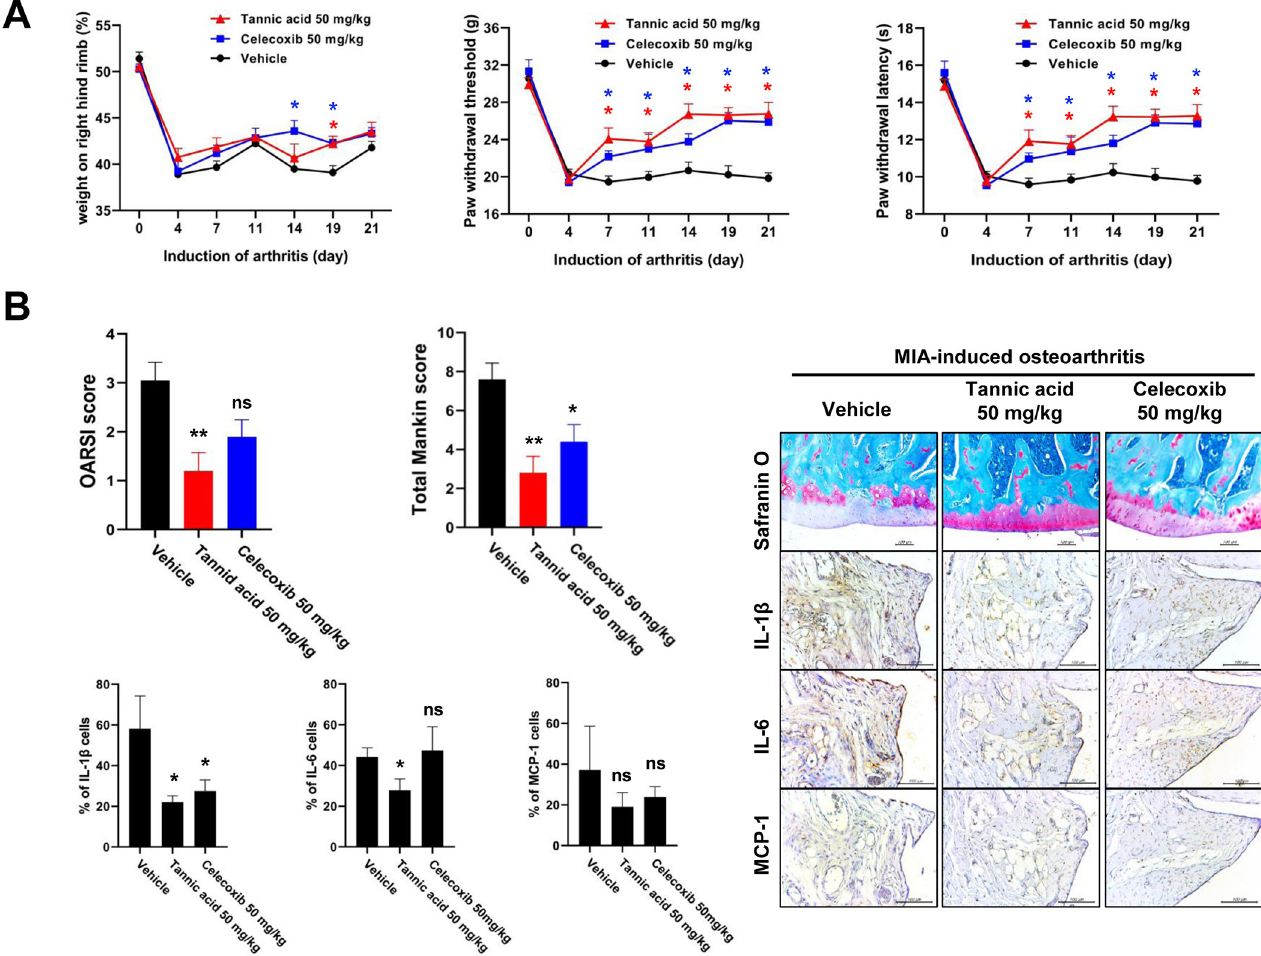
Fig 5. Therapeutic effect of TA in MIA-induced OA rat model. (A) Rats were injected with 1 mg of MIA in the right knee. TA (50 mg/kg) was administered orally daily for 3 days after MIA injection. Behavioral tests of mechanical hyperalgesia were evaluated using a dynamic plantar esthesiometer (n = 5). Paw withdrawal latency (PWL) and paw withdrawal threshold (PWT) were conducted right before the administration of TA. The weight balance of MIA-treated rats was analyzed using a capacitance meter. Celecoxib (50 mg/kg) was used as a positive control. Data are presented as the mean ± SD of three independent experiments. * p < 0.05 compared with vehicle group. (B) The knee joints from the OA rats treated with either TA, celecoxib, or vehicle control were stained with HE and Safranin O. The joint lesions were graded on a scale of 0–13 using the modified Mankin scoring system, giving a combined score for cartilage structure, cellular abnormalities, and matrix staining. Immunohistochemical analysis was performed to identify the expression of IL-1 β , IL-6, and MCP-1 in the articular cartilage. The data are expressed as mean ± SEM for five animals per group. * p < 0.05, ** p < 0.01, and *** p < 0.001 compared with the MIA- induced OA